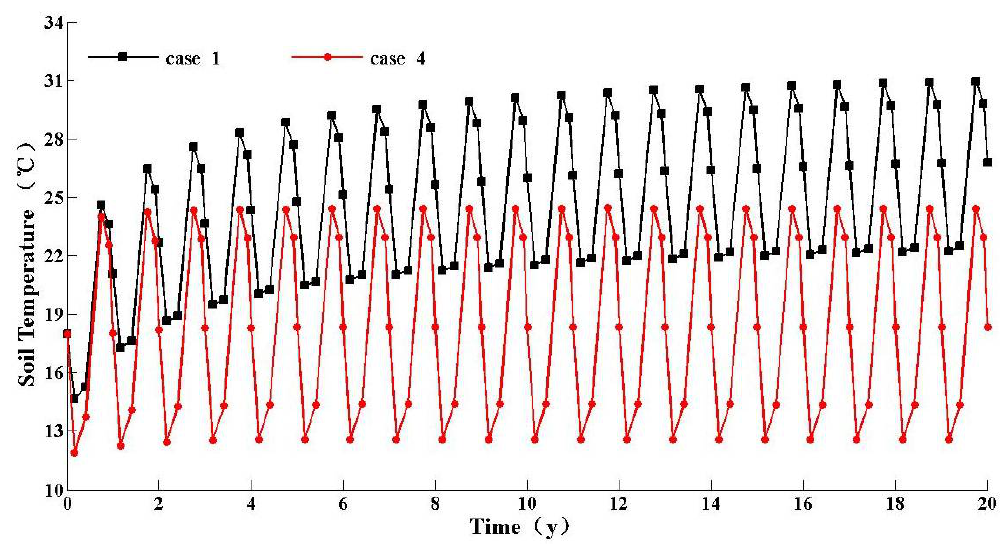
Figure 6. Average soil temperatures of 20 years of operation.